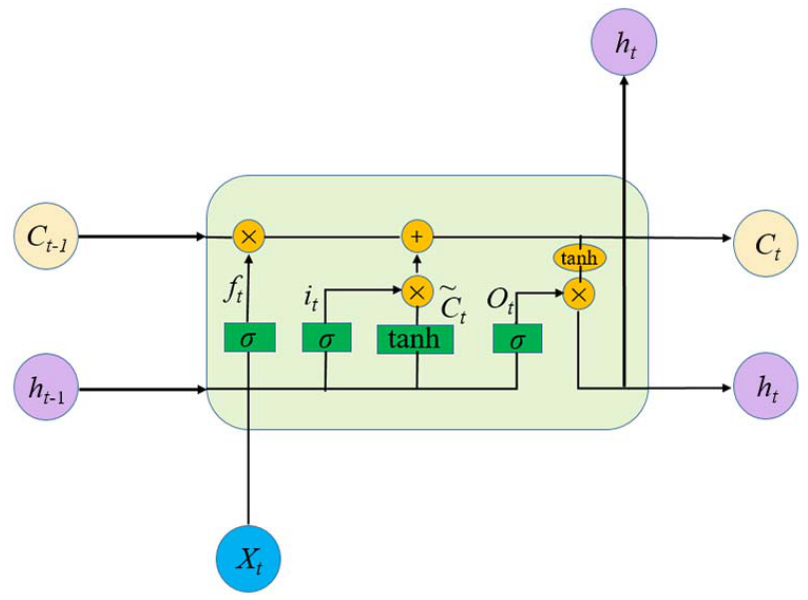
Figure 4. Structure of LSTM memory